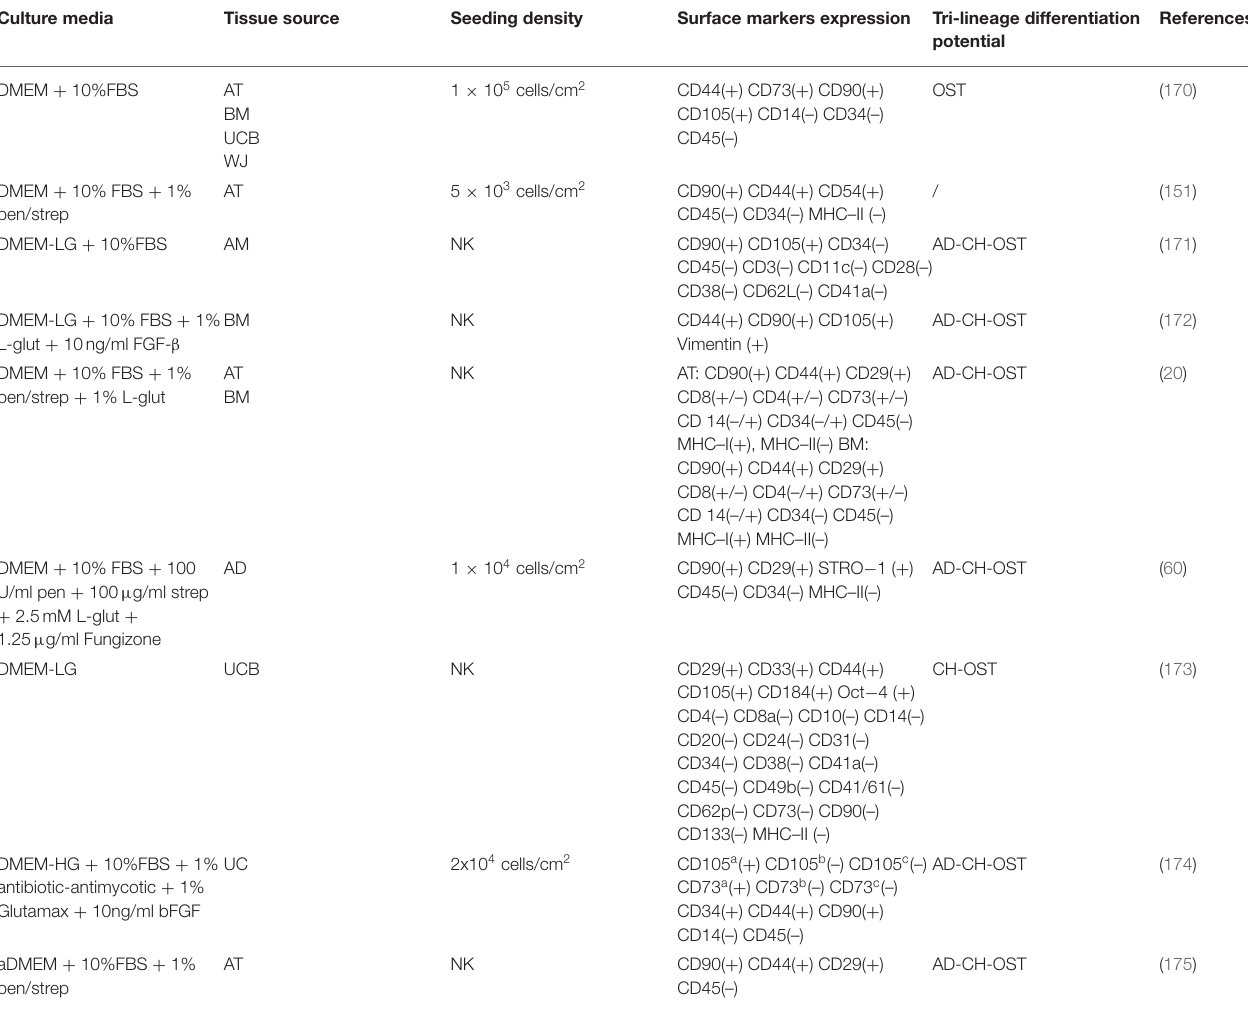
TABLE 3 | Characterization of canine mesenchymal stromal cells cultured in DMEM. Culture